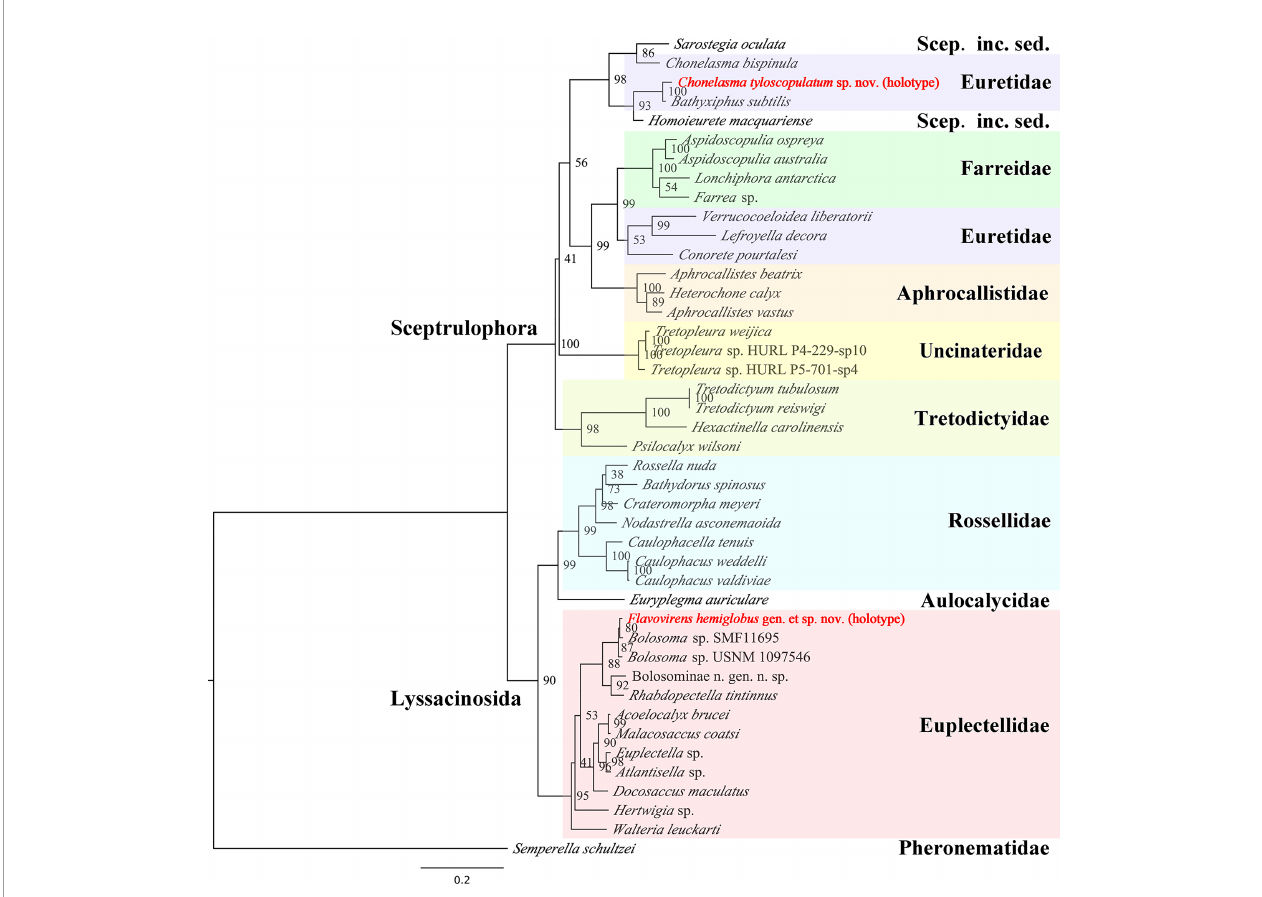
FIGURE 5 | Maximum-likelihood phylogenetic tree of 43 species of hexactinellid sponges inferred from the concatenated alignment of four molecular markers (18S rDNA, 28S rDNA, 16S rDNA sequences and COI gene) with RAxML. Scep. inc. sed. refers to Sceptrulophora incertae sedis . Bootstrap values are shown next to nodes (based on 1000